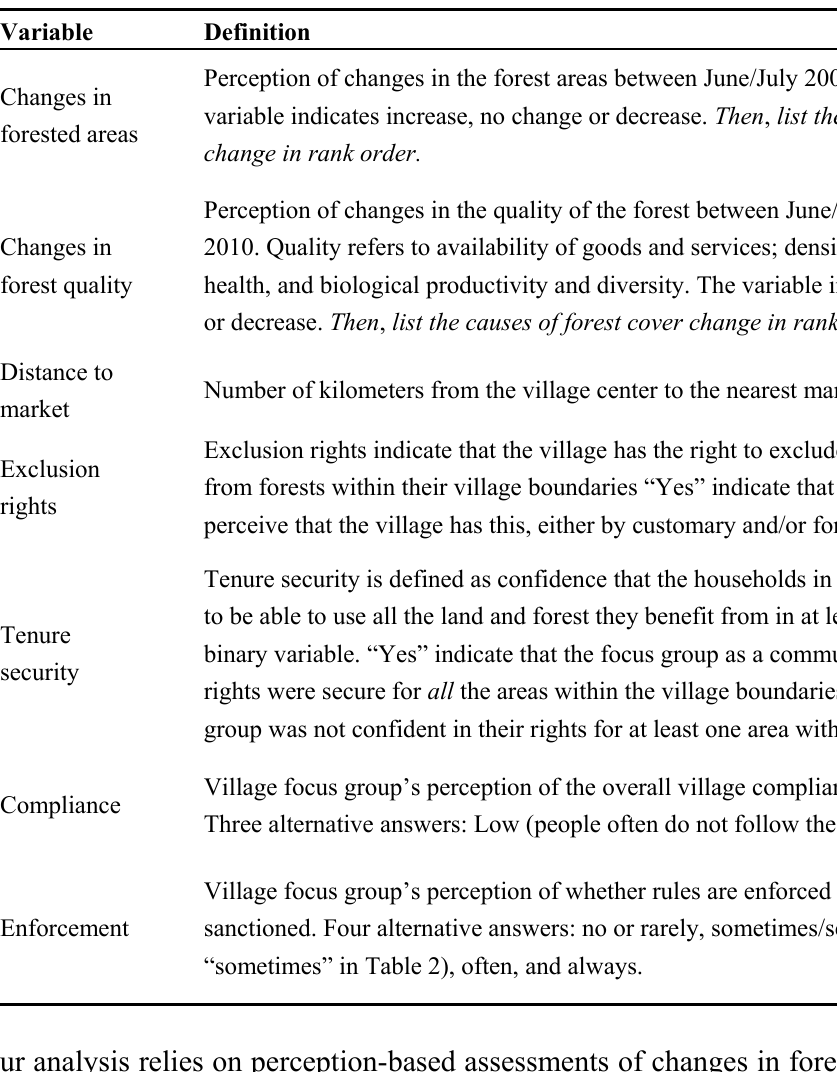
Table 2. Overview of the Main Variables Used in the